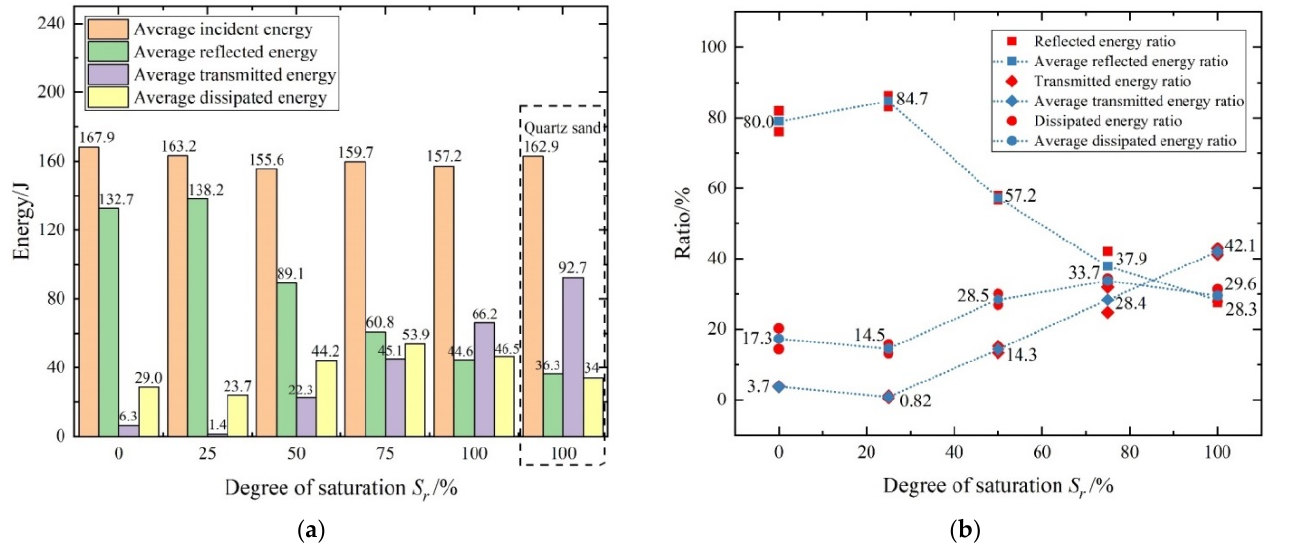
Figure 10. ( a ) Energy distribution histogram of specimens with different saturations after impact. ( b ) Ratio curve of each part energy to incident energy.